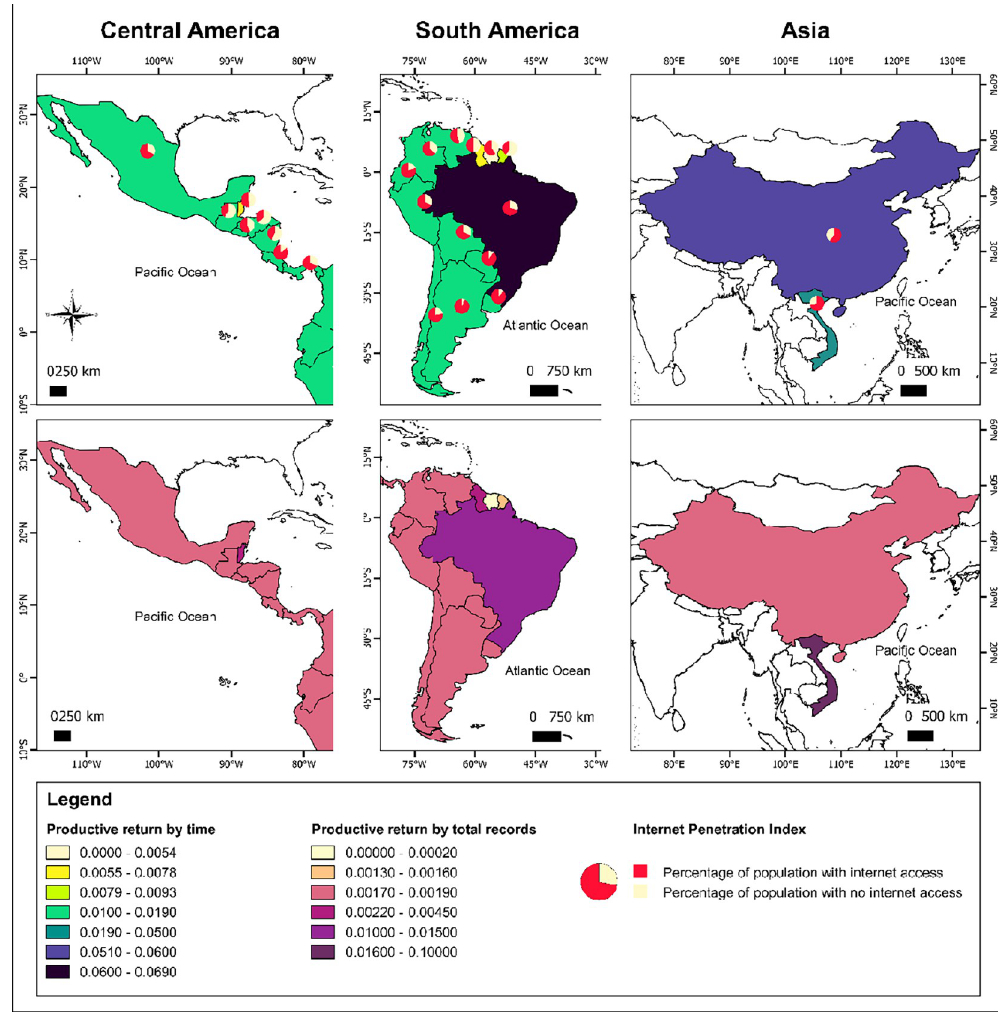
Fig 6. Internet penetration index and